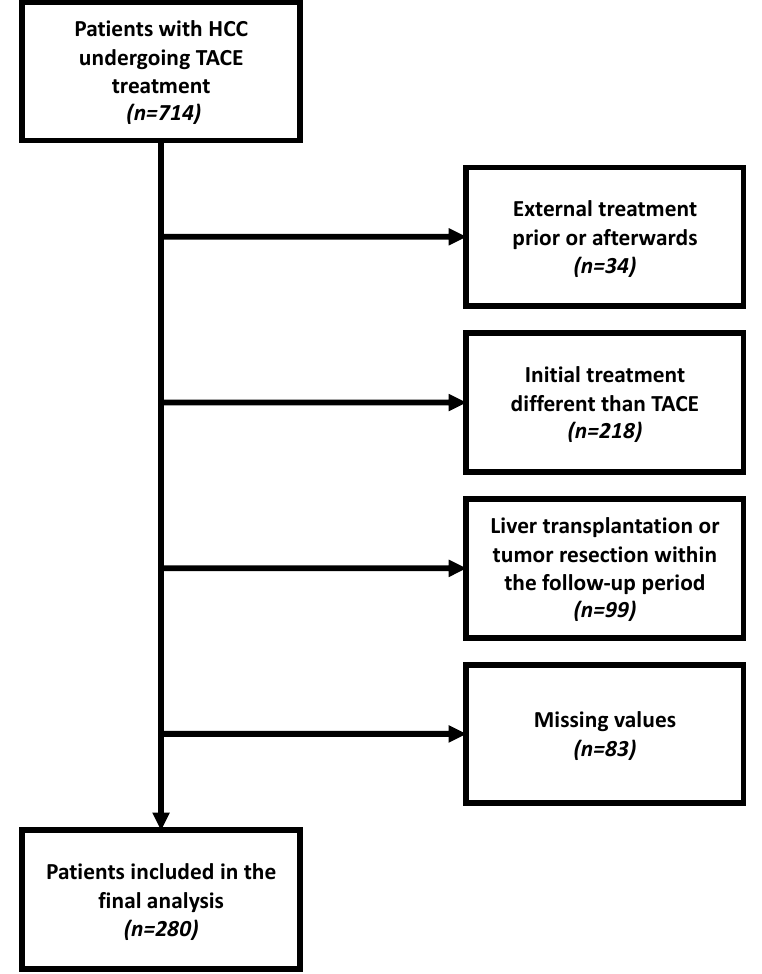
Figure 1. Flowchart of the inclusion of patients for whom the ALBI-PNI score could be evaluated.